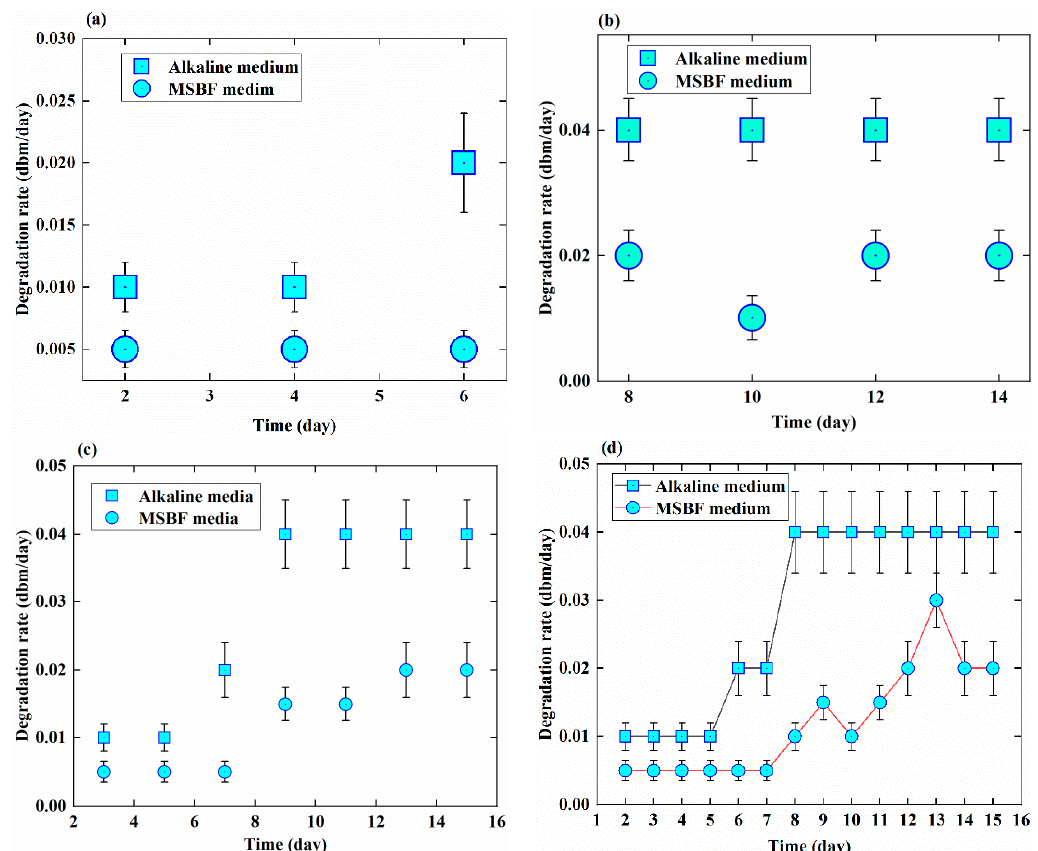
Figure 6. Degradation rate of the EMBAB at different times in alkaline and MSBF media. The graphs show: ( a , b ) degradation rate on the even number days; ( c ) degradation rate on odd number days; ( d ) degradation rate over 15 days.